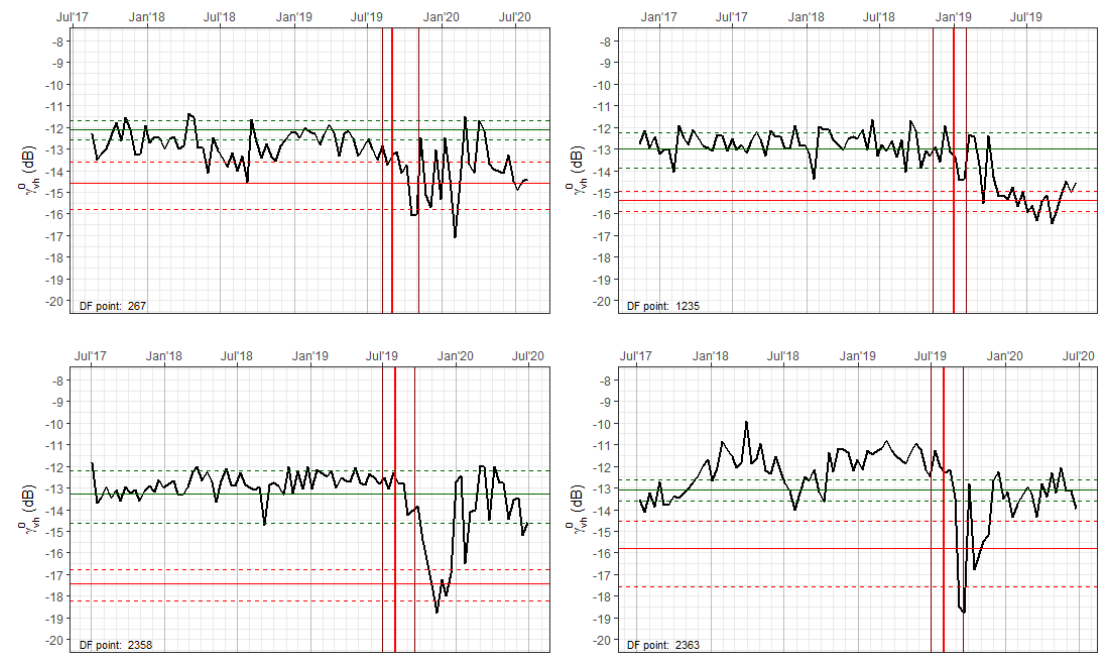
Figure 6. Results of the finite mixture model algorithm in four di ff erent deforested locations in the Amazon basin. The time series are speckle-filtered non-stabilized VH backscattering. The continuous and dashed horizontal lines represent the mean and the 2 σ interval of the two modeled components, assumed to represent forest (green) and deforested classes (red). The red thin vertical lines represent the location reported before and after dates of deforestation. The red bold line represents the reported date of